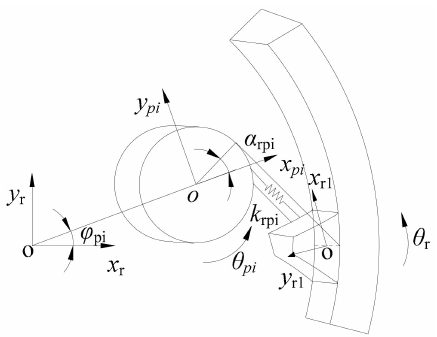
Figure 4. Internal meshing